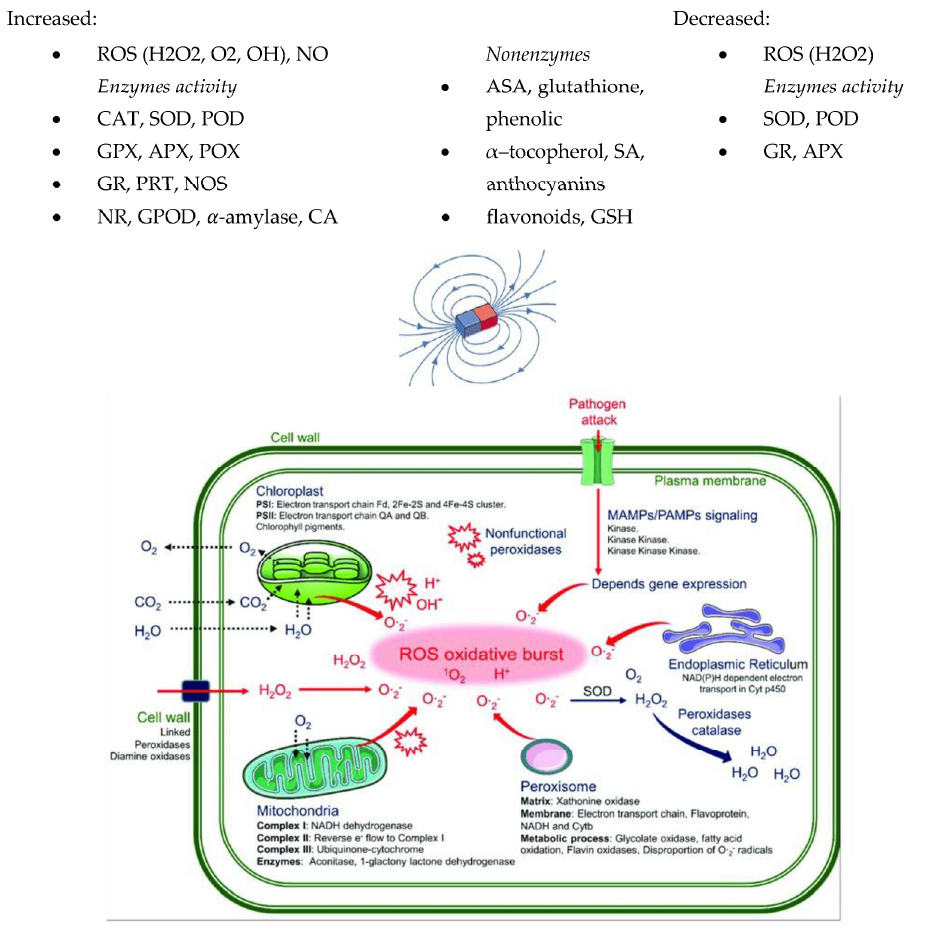
Figure 2. The summary of the effects of MFs on ROS, NO content, and enzyme activity [120]. Cop- yright Plants 2021. Copyright Plants